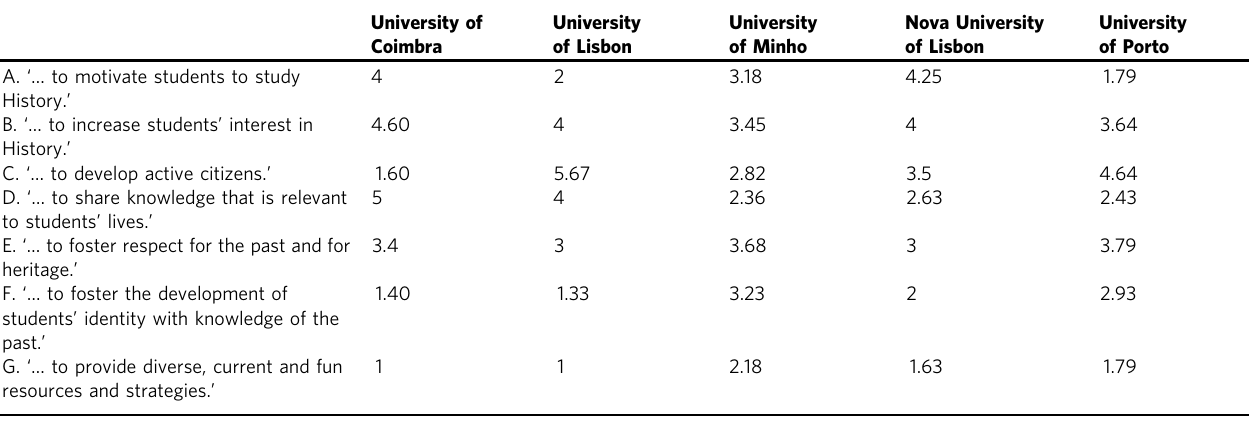
Table 5 Average valuation given to the answer options for question 2 ‘ The purpose of becoming a History Teacher is …’ by university.